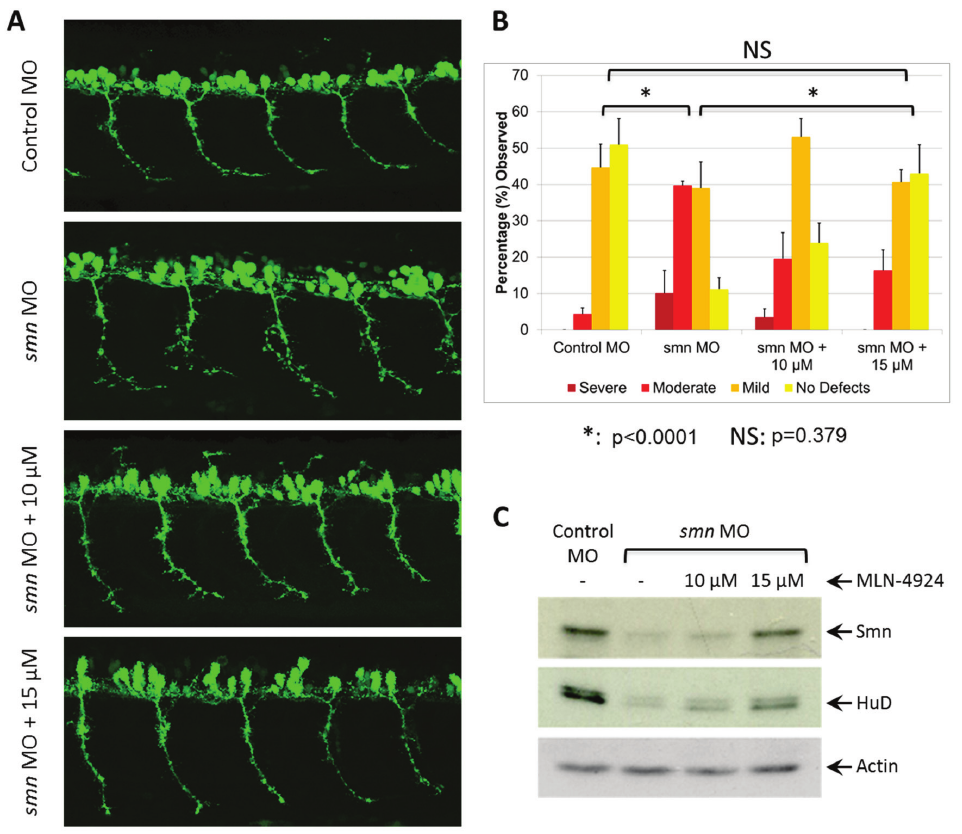
Figure 5. MLN4294 rescues the abnormal neuron outgrowth in Smn-depleted zebrafish. ( A ) Representative lateral views of motor axons in Tg ( mnx1:GFP ) zebrafish embryos expressing GFP in motor neurons and injected with control MO and then grown in 10 or 15 µM MLN4294. ( B ) Quantification of the effects of MLN4294 on motor axon development in zebrafish. Motor axons were scored in Tg ( mnx1:GFP ) embryos injected with control MO, and subsequently (10 hrs post-injection) incubated in 10 or 15 µM MLN4294. Embryos were classified as severe, moderate, mild, or no defects based on the severity of motor axon defects, and the percentage of each group is shown. Data in all graphs are represented as mean and SEM. ( C ) Western blot analysis of Smn and HuD protein following treatment with MLN4294. Quantification of the results is shown in Figure